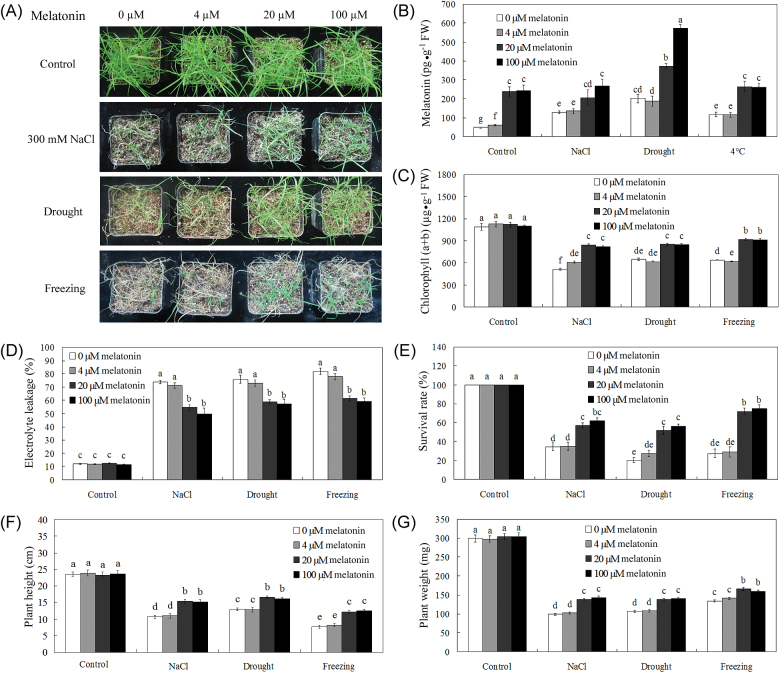
Application of exogenous melatonin improved abiotic stress resistance in bermudagrass. (A) Growth of 28-day-old plants with different melatonin treatments and under control, salt, drought, or freezing stress conditions. The picture is representative of one pot for every treatment in one concentration of melatonin, and at least nine pots with ~120 lines were used for the stress treatments with similar results. (B) Melatonin content of 28-day-old plants with different melatonin treatments and under control, 300mM NaCl, drought stress, and cold (4 °C) stress conditions for 14 d. (C, D) Chlorophyll (C) and EL (D) of 28-day-old plants with different treatments (0, 4, 20, and 100 μM melatonin, respectively) under control, 300mM NaCl, drought stress, and freezing stress conditions for 21 d. (E) The survival rate of bermudagrass plants after 25 d of treatments of control, 300mM NaCl, re-watered from drought, and freezing stresses. (F, G) Plant height (F) and fresh weight (G) of bermudagrass plants after 24 d of treatments of control, 300mM NaCl, re-watered from drought, and freezing stresses. The results shown are the means ±SE (n=3 for B, n=4 for C–E, and n=12 for F and G), and bars with different letters above the columns of figures indicate significant differences at P<0.05 (Duncan’s range test). (This figure is available in colour at JXB online.)